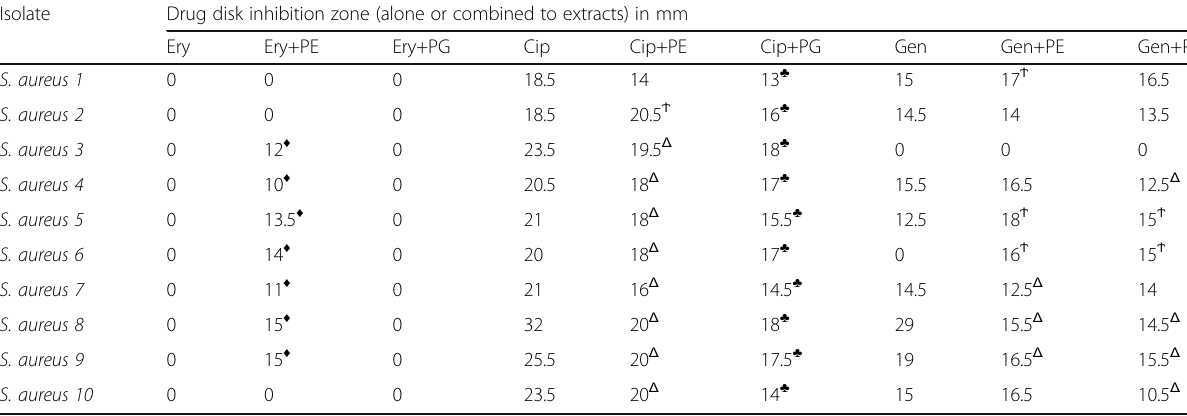
Table 4 Interference of the extracts on antimicrobial drugs Isolate Drug disk inhibition zone (alone or combined to extracts) in